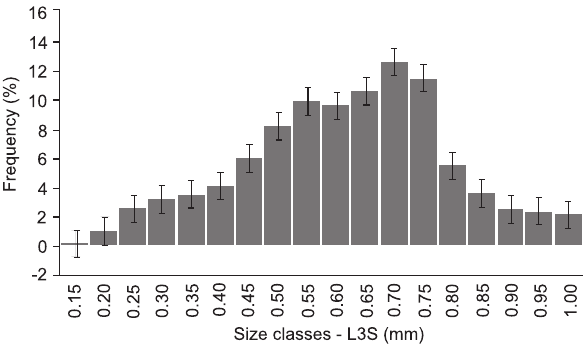
Figure 5. Distribution frequency of size classes based on the width of 3 rd setiger (L3S) of 9,242 individuals from Manguinhos beach during a twelve-month period. Note: vertical bars represent the standard